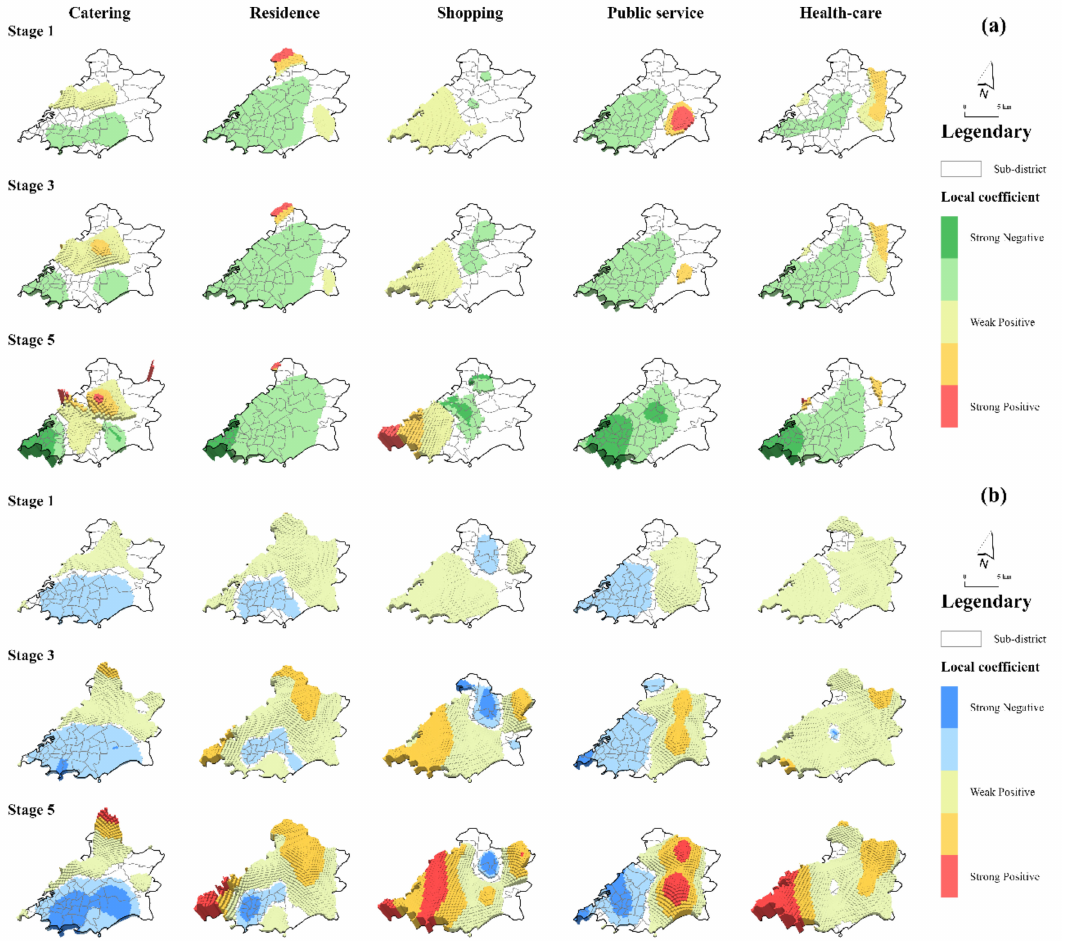
Figure 4. Estimation results for the GTWR coefficients of FD ( a ) and FA ( b ) in various gathering